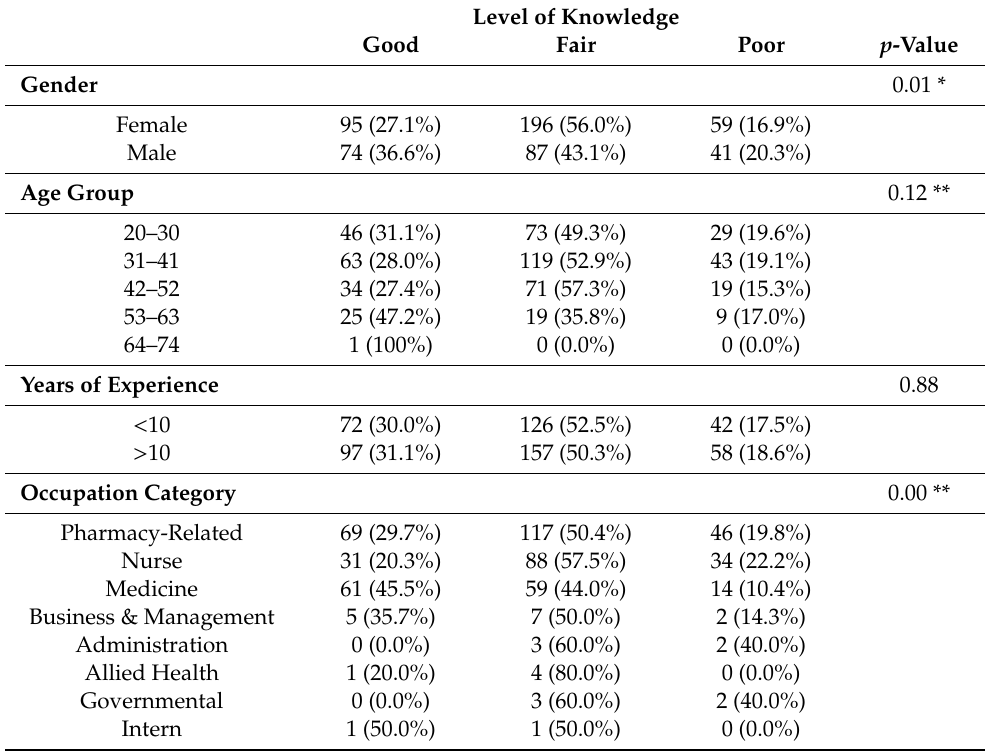
Table 3. Comparison of the level of knowledge between di ff erent